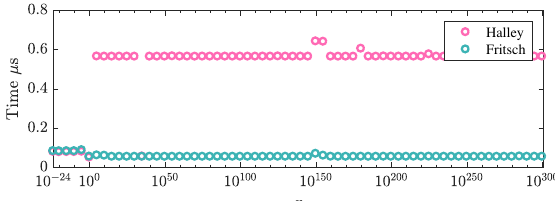
Figure 10. Averaged processing times required to compute W ( x ) using Halley’s method and Fritsch’s